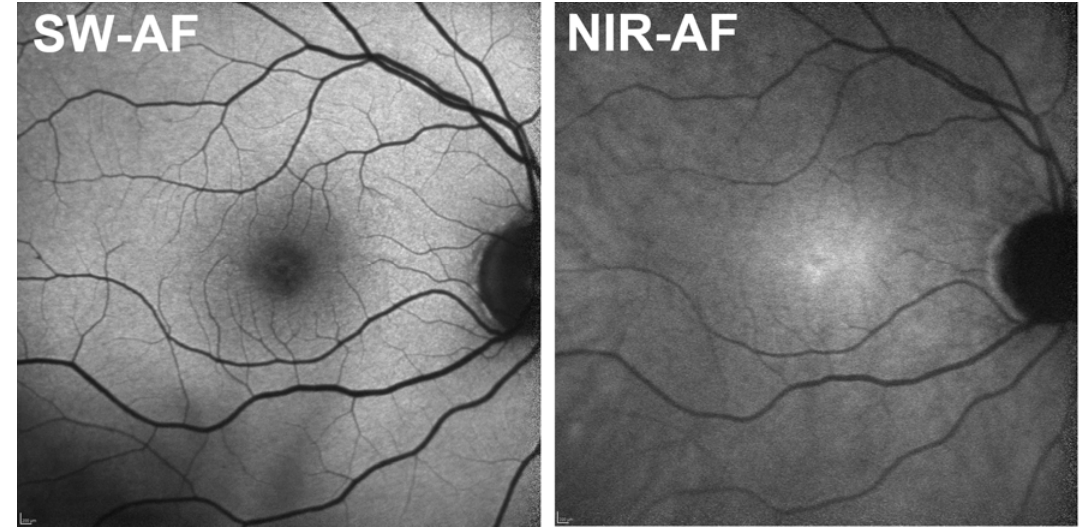
Figure 1. Short-wavelength (SW-AF) and near-infrared (NIR-AF) fundus autofluorescence. Images were obtained with 488 nm (SW) and 787 nm (NIR) excitation.